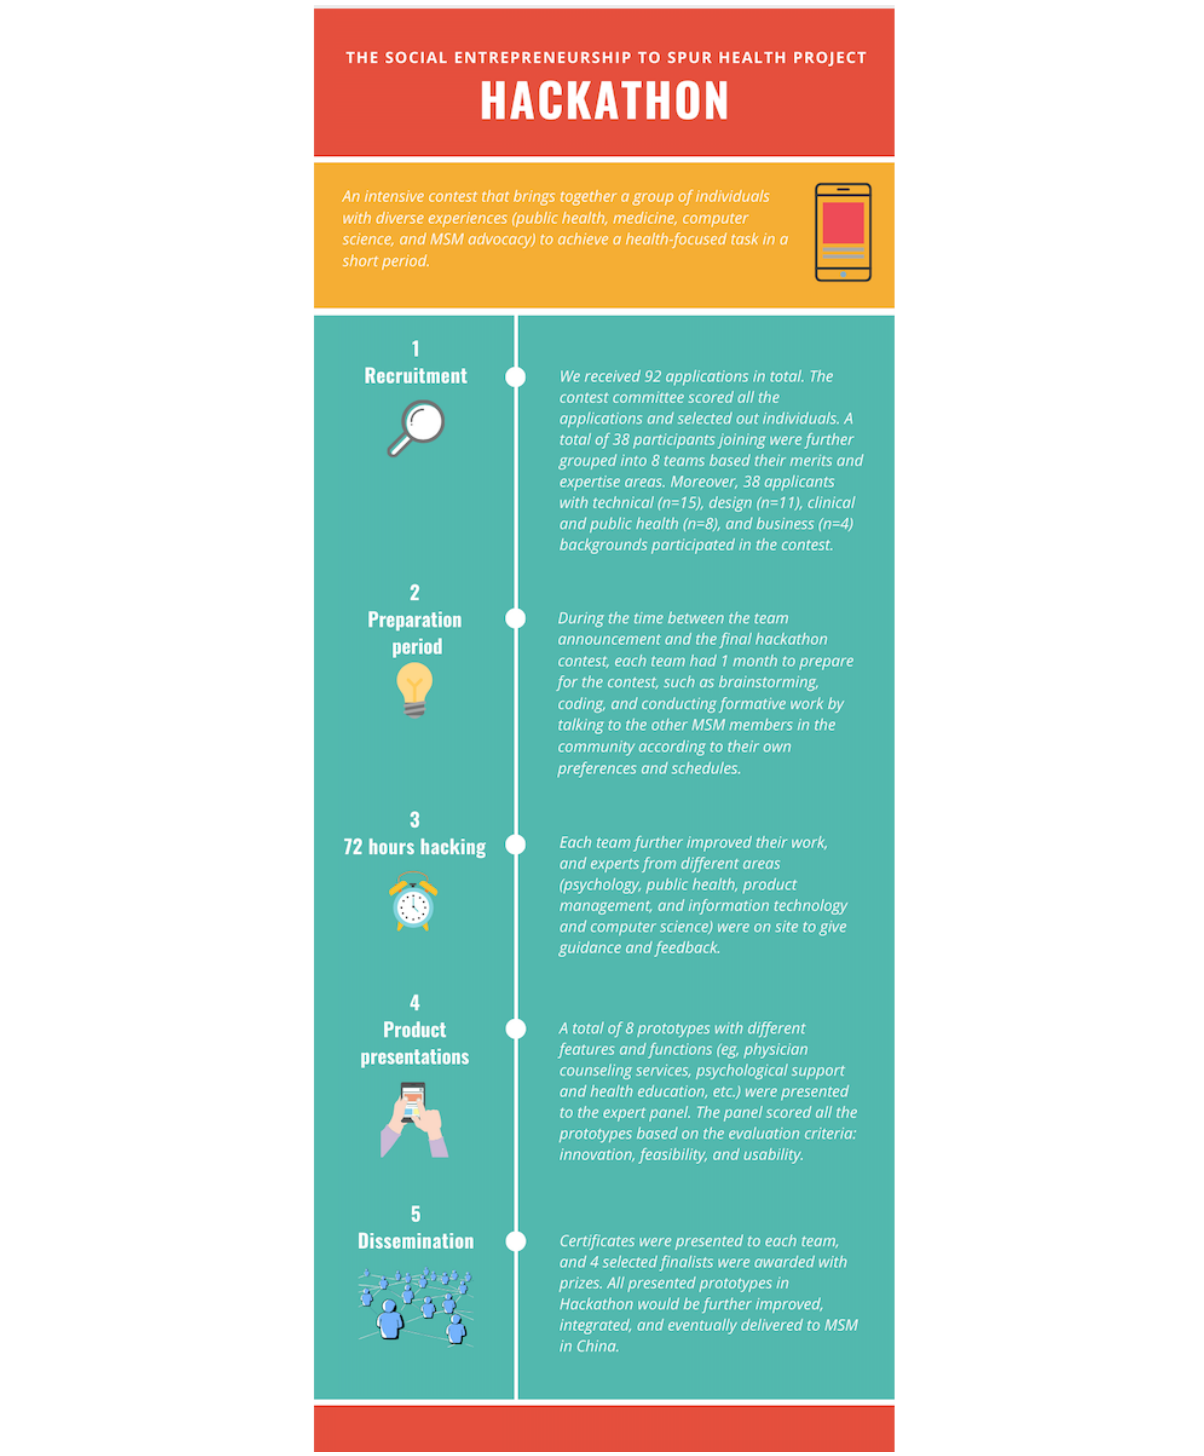
Figure 2. Flowchart of preparation for the hackathon